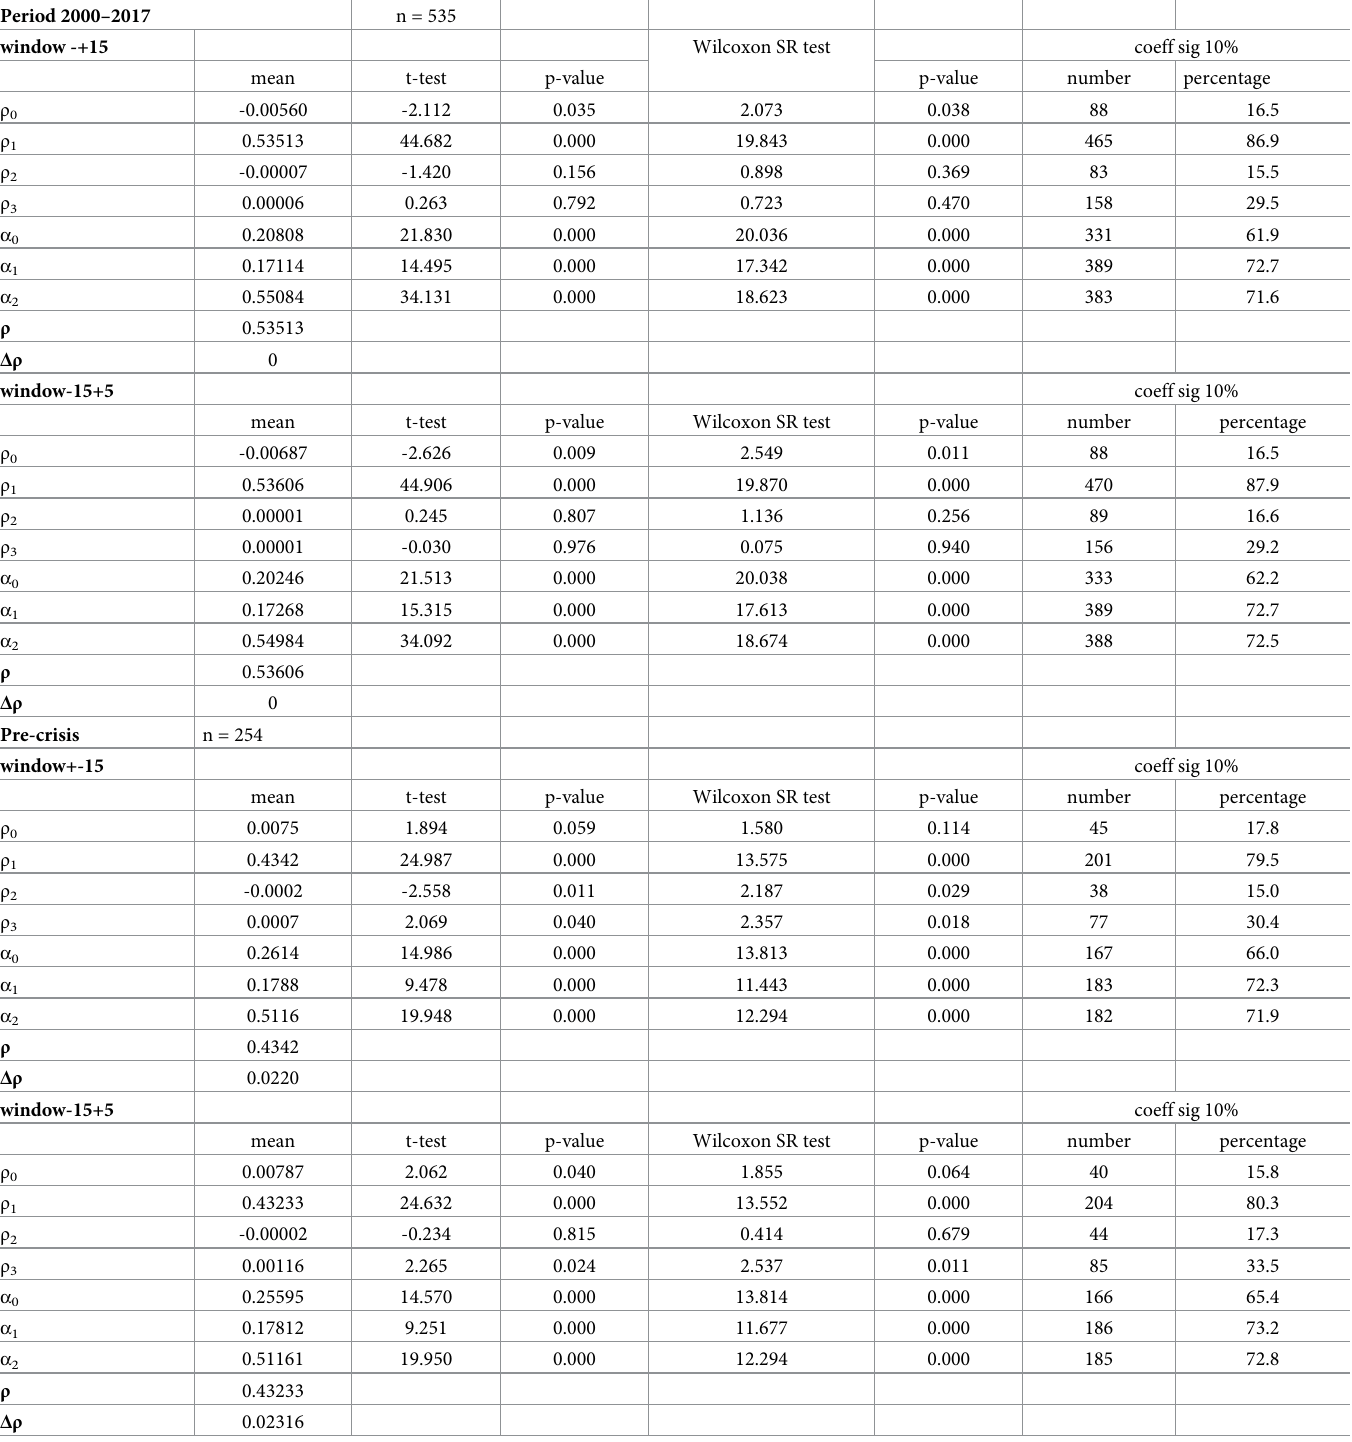
Table 4. Summary results–normalized: